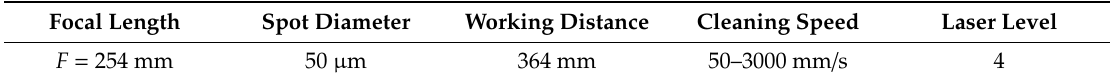
Table 3. Laser cleaning machine parameters.